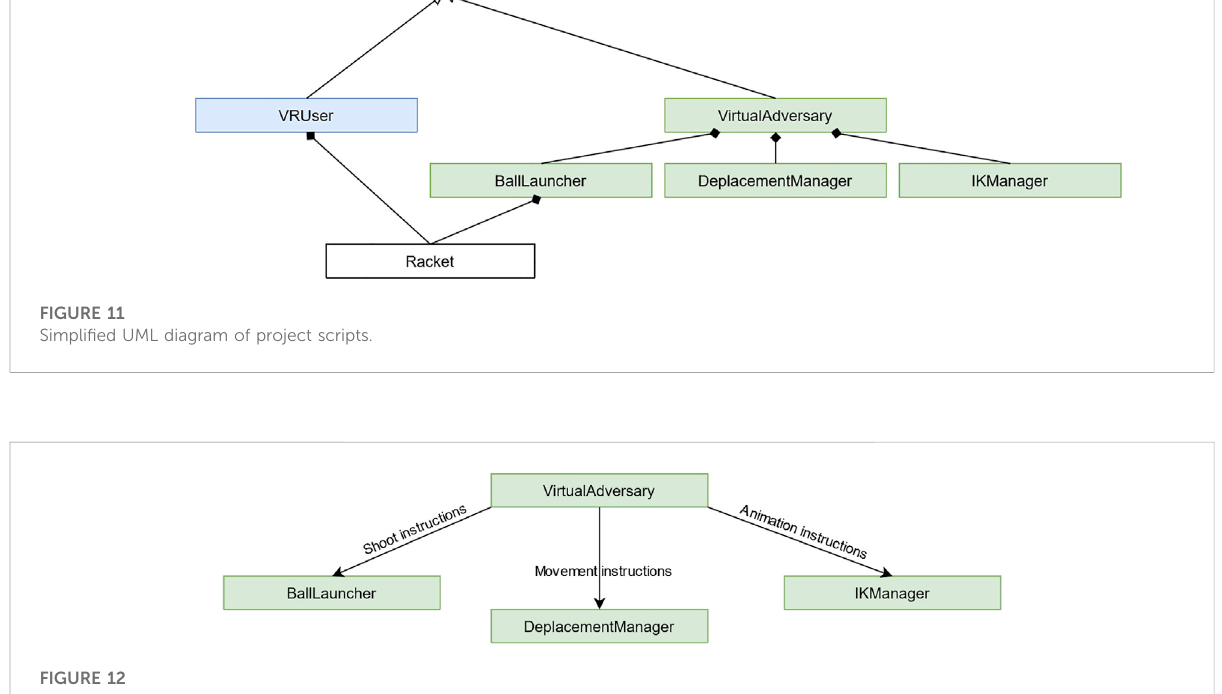
FIGURE 12 Diagram of the virtual opponent management